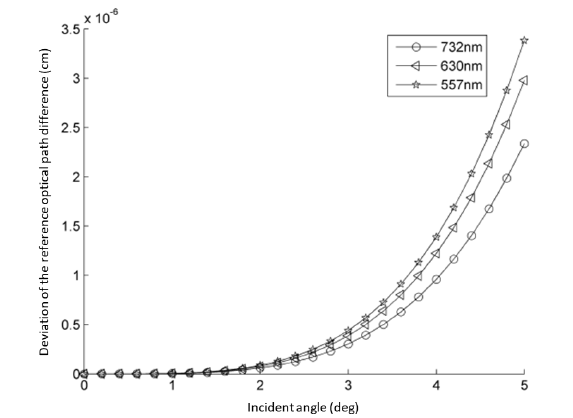
Figure 2. The deviation of the reference optical path difference with the incident angle